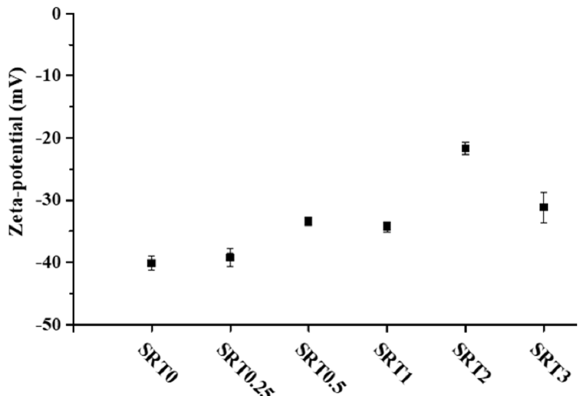
Figure 4. The zeta − potential values of 0.001 wt.% aqueous dispersion of the initial SrTiO 3 and SRTX samples (pH = ~9.15).